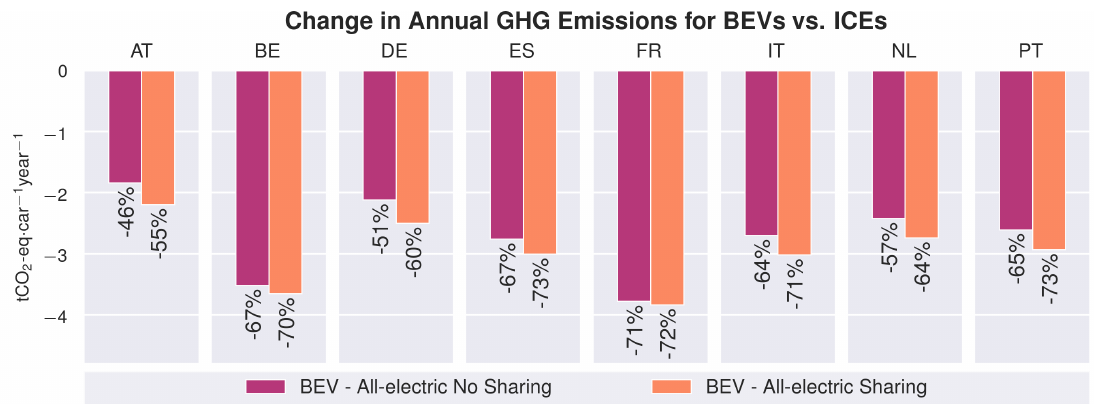
Figure 6. Greenhouse gas emission reduction potentials for battery-electric vehicles in the eight selected countries. Data are shown as the change in annual emissions related to car use, per car, and includes both energy use (fuel or electricity) and upstream emissions related to manufacturing of the vehicles.